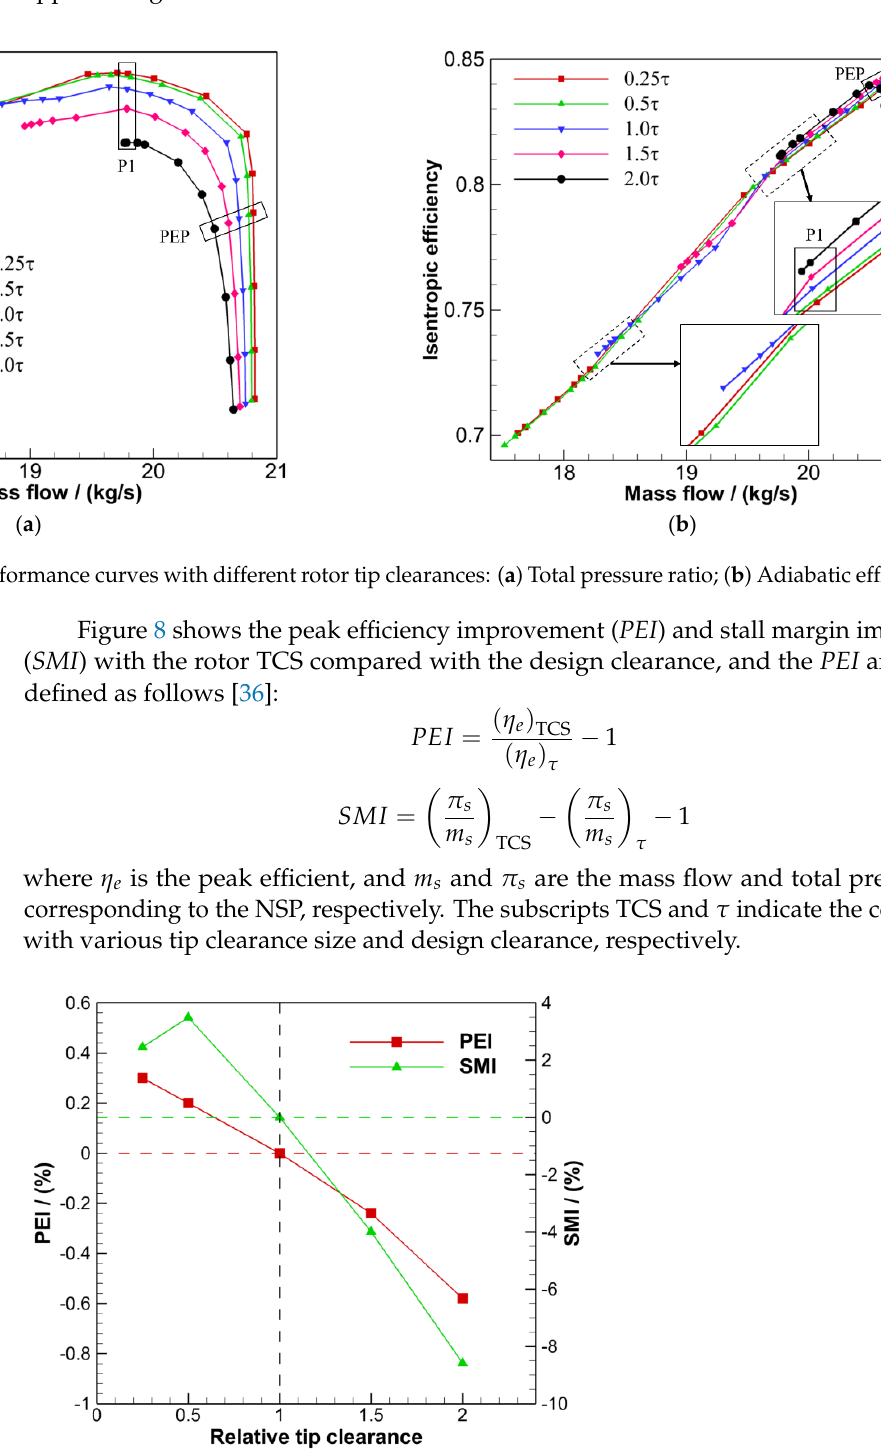
Figure 8. The improvement of peak efficiency and stall margin with rotor tip clearance